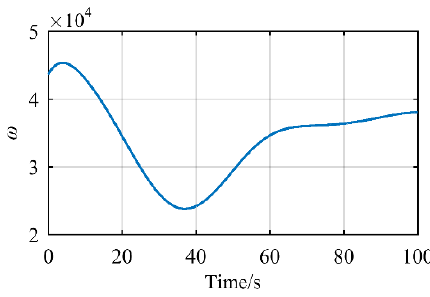
Figure 15. The variety of maneuverability index ω